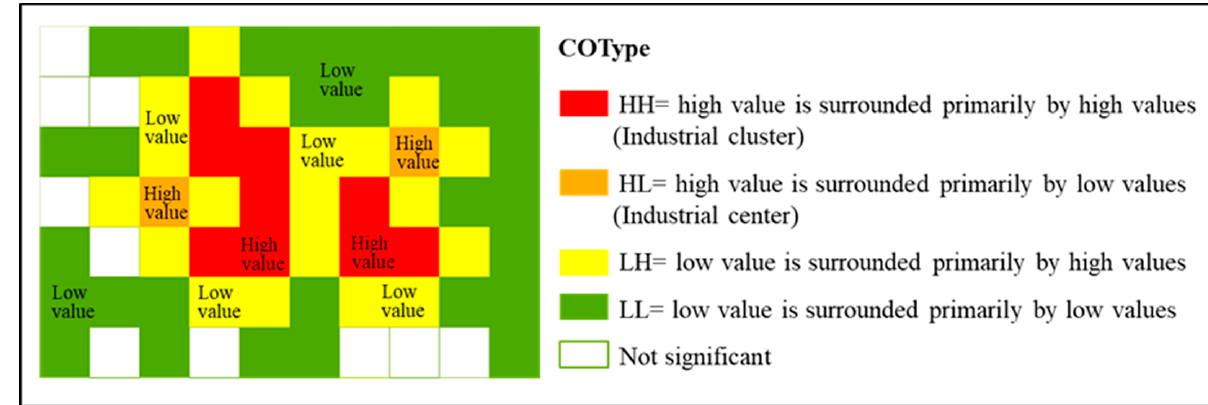
Figure 3. Distribution analysis of Industrial spatial concentration (Local Moran’s I).